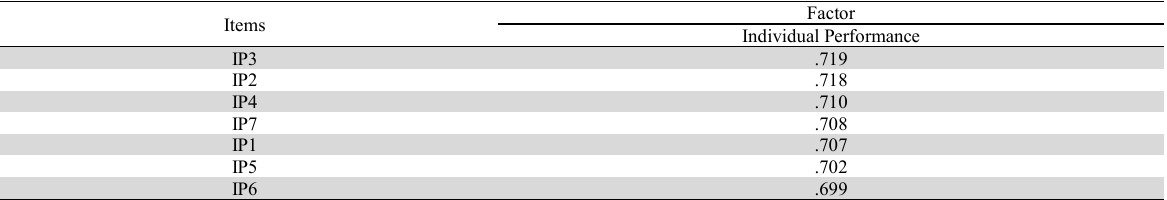
Matrix of factors of Individual Performance scale